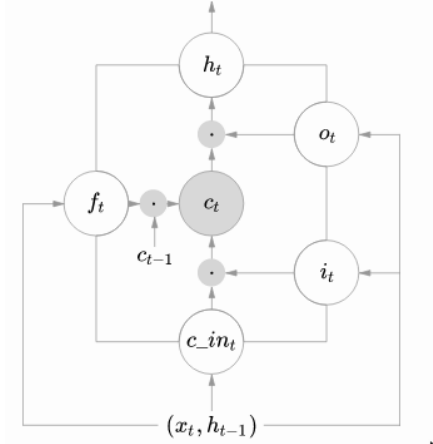
Figure 3. LSTM’s cell gates and